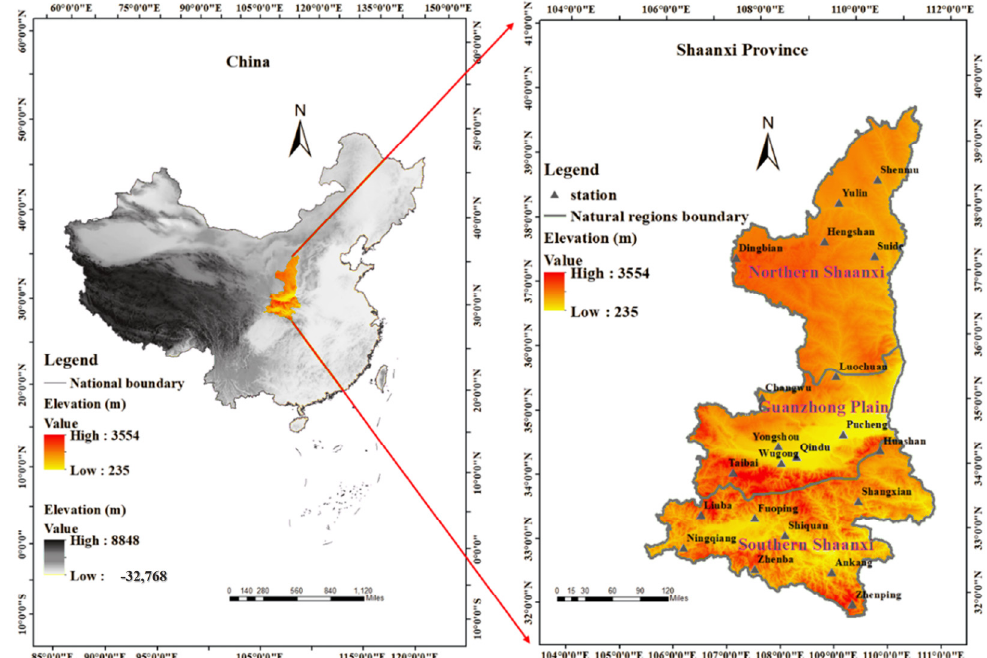
Figure 2. Study area and stations.